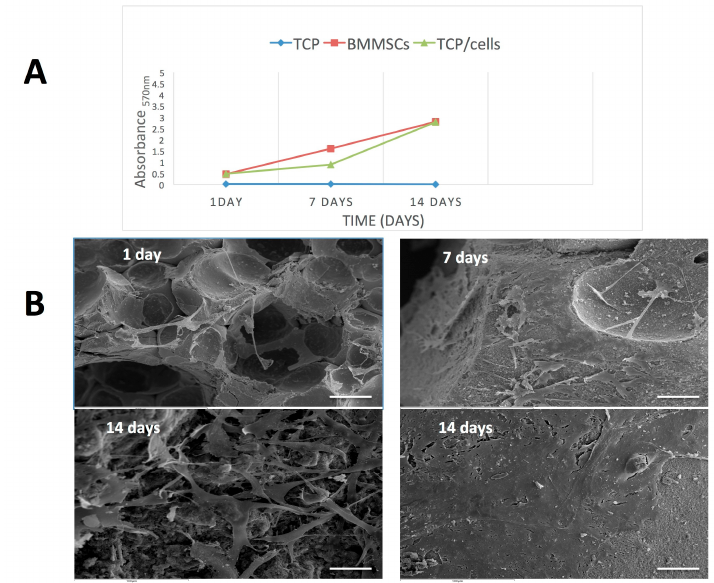
Figure 2. ( A ) MTT assay results of h BMMSCs and β -TCP/ h BMMSCs construct. Results are